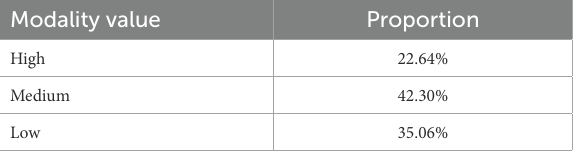
TABLE 6 The distribution of modality values in the original text corresponding to the three translations. Modality